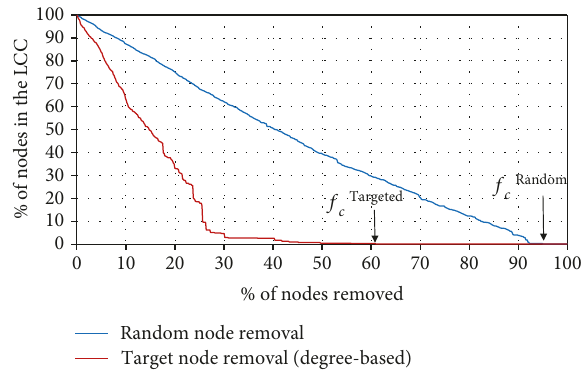
Figure 7: Percentage of nodes in the largest connected component under random and targeted (degree-based) node